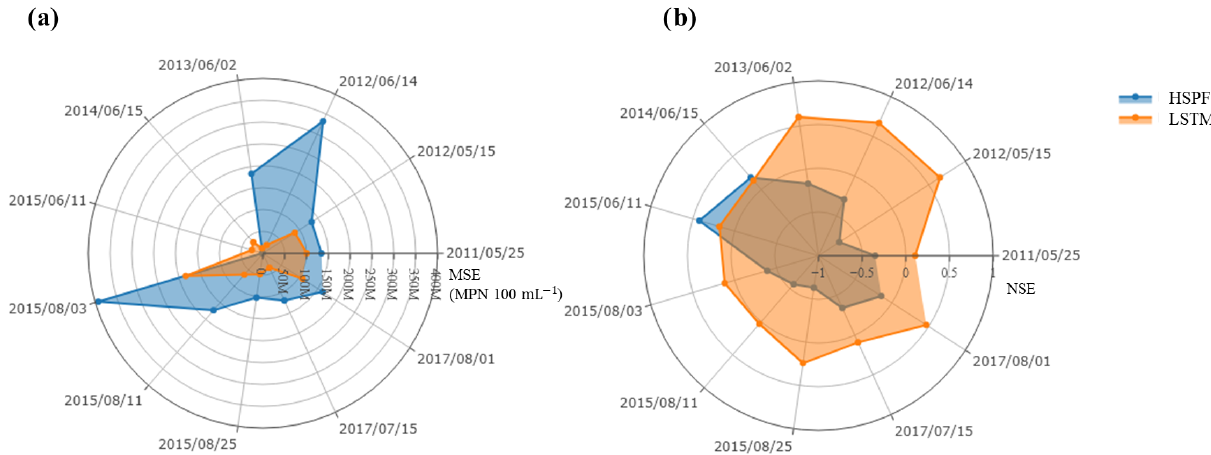
Figure 8. Comparison of the E. coli simulation during storm events: (a) MSE values and (b) NSE values.